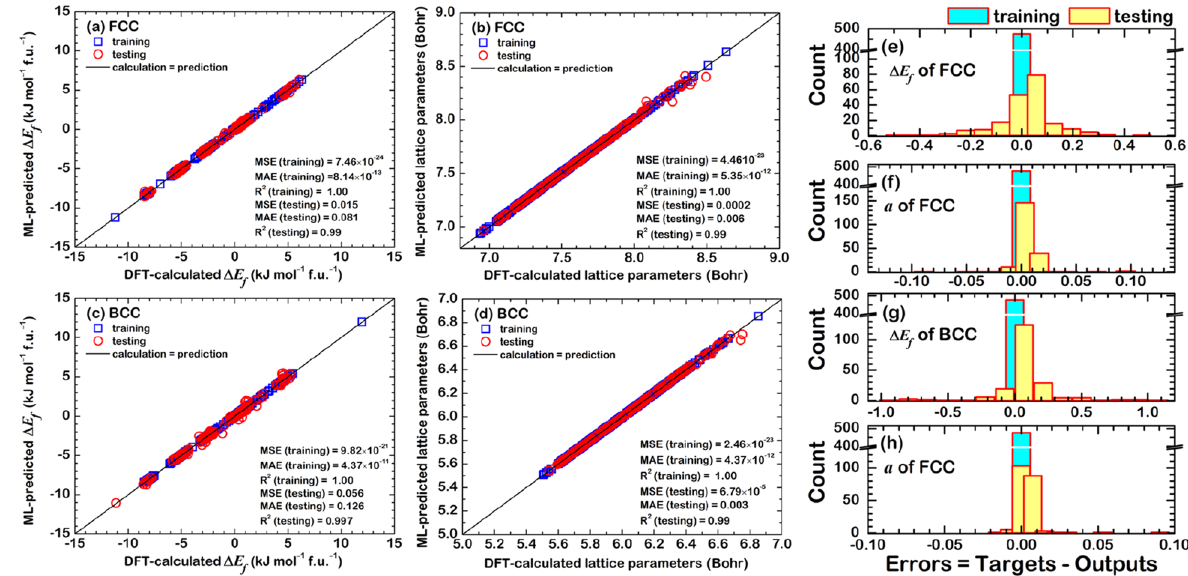
Figure 6. ML-predicted results compared with DFT-calculated data for ( a ) (cid:31) E f (FCC), ( b ) (cid:31) E f (BCC), ( c ) a (FCC), and ( d ) a (BCC). Error distribution in the testing is shown in ( e )–( h